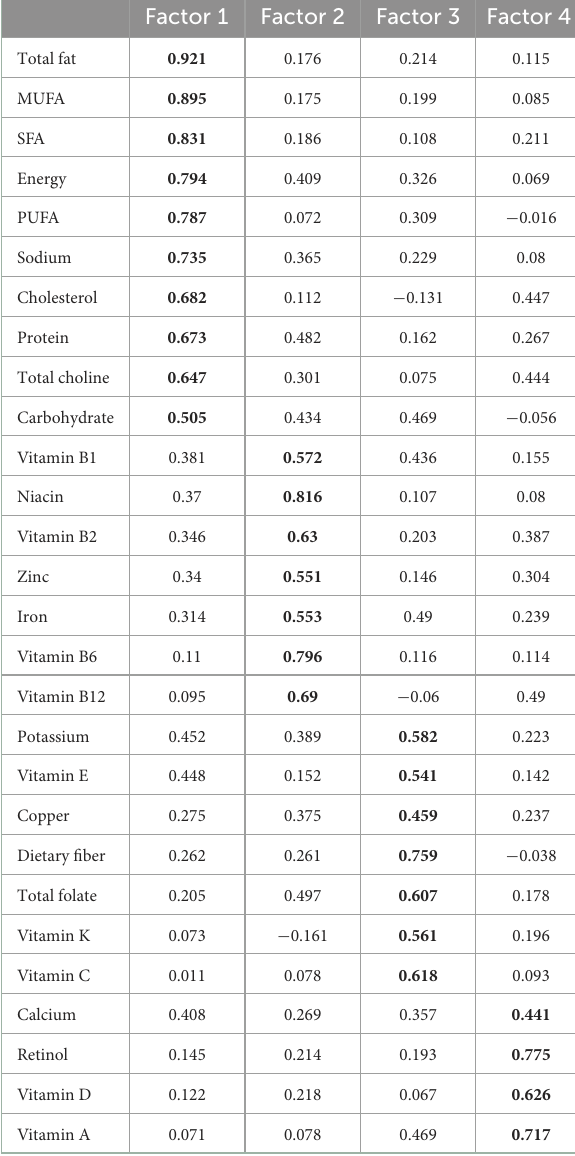
TABLE 3 The result of factor rotation.